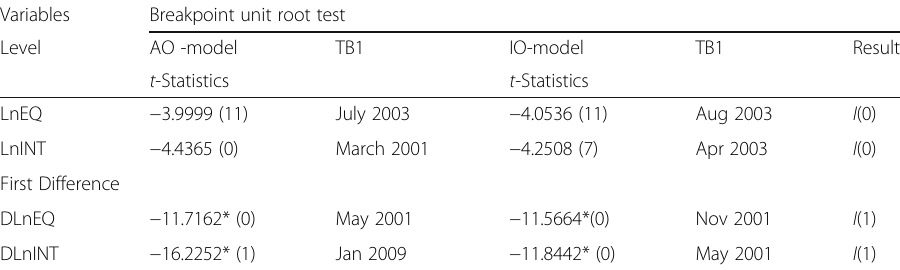
Table 1 Perron (Perron, 1989) Test with one endogenous structural break